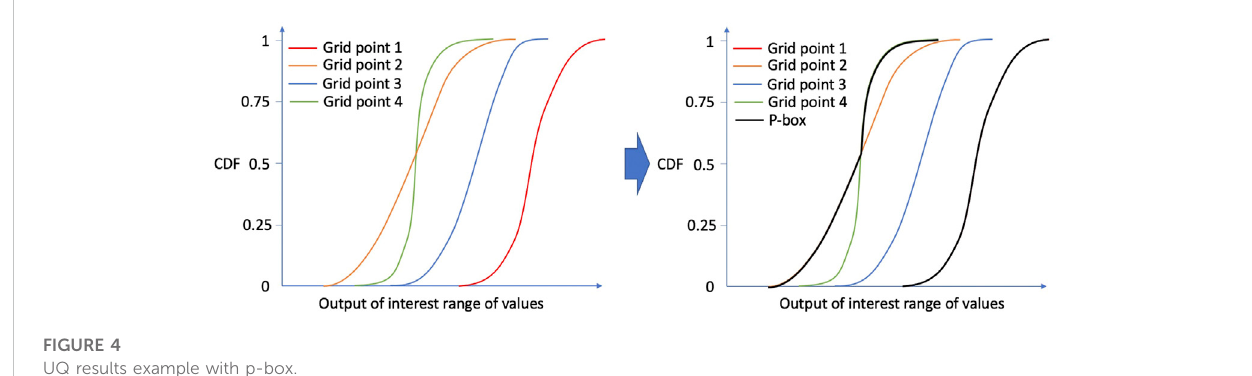
FIGURE 4 UQ results example with